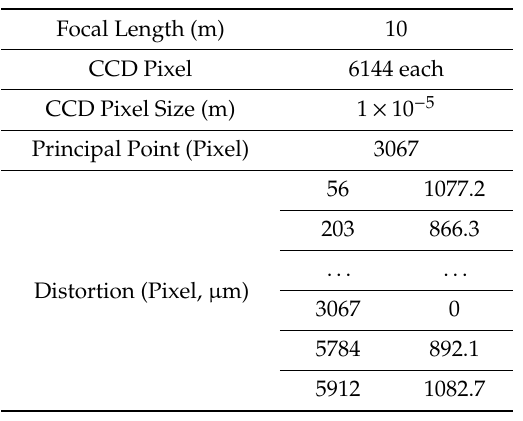
Table 3. Remote Sensing Camera Parameters.